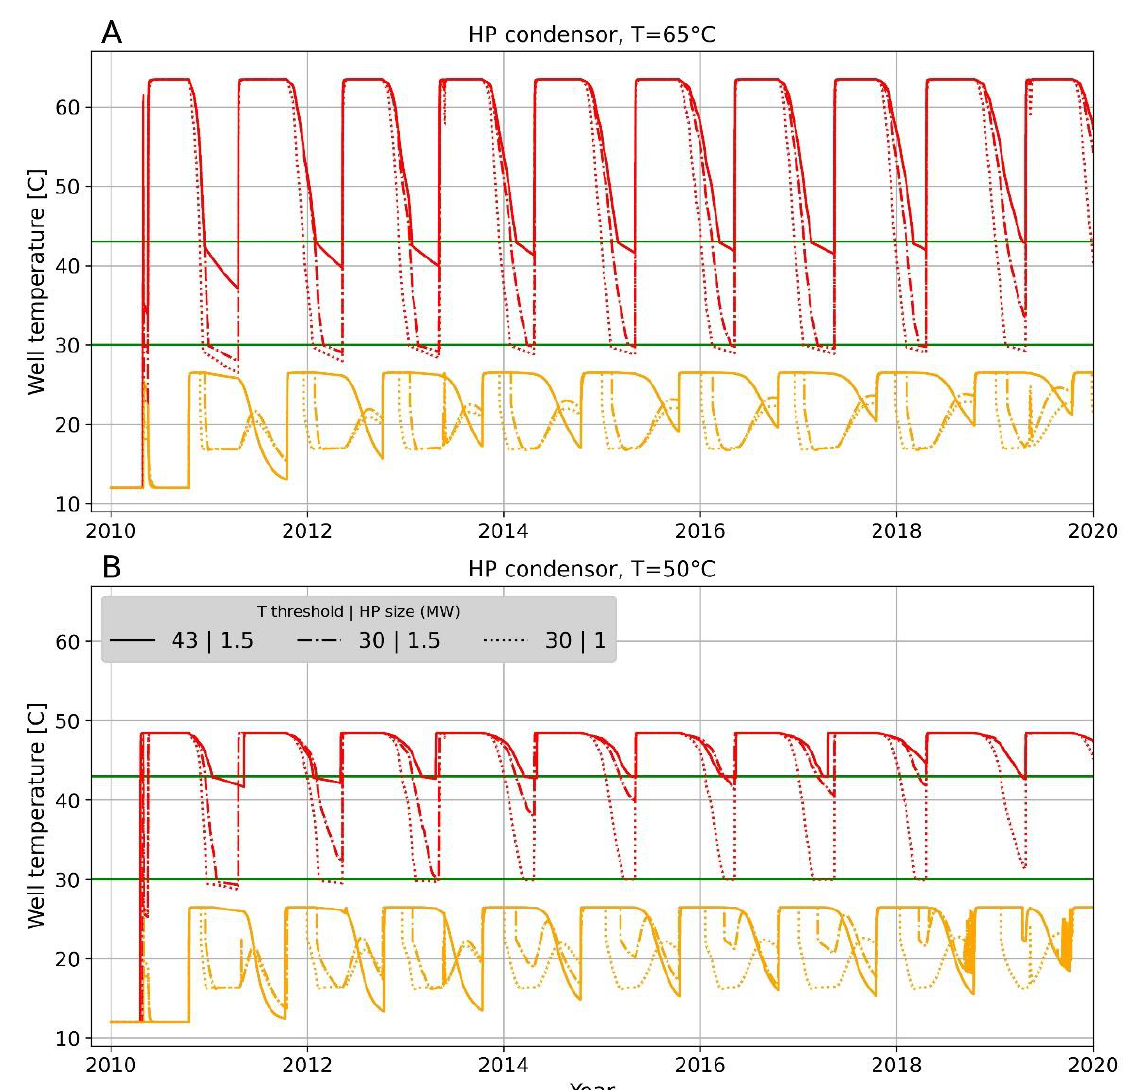
Figure 7. Overview of the temperature variations of the hot well and warm well for a 65 ◦ C condenser temperature ( A ) and 50 ◦ C condenser temperature ( B ). Scenarios with a 1.5 MW el heat pump are shown, both with (65|30|1.5 or 50|30|1.5) and without (65|42|1.5 and 50|43|1.5) the HT-ATES feeds heat pump mode. Furthermore, scenarios with a 1 MW el heat pump are included (65|30|1 and 50|30|1). The green lines show the threshold temperatures at 43 ◦ C and 30 ◦ C (with the HT-ATES feeds heat pump mode). The legend in ( B ) is valid for ( A ) as well.